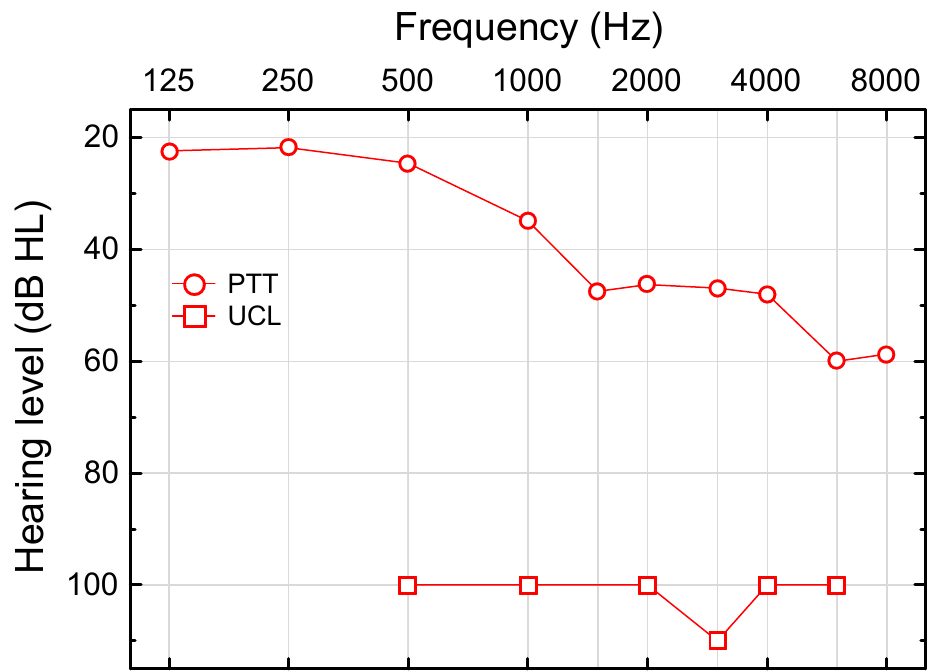
Figure 1. Median pure-tone threshold (PTT) and median uncomfortable level for pure tones (UCL) as a function of frequency in the better ear (n = 11 at all the frequencies, except for PTT at 8000 Hz, n = 10). The typical hearing dynamic range decreased from 75 dB at 500 Hz to 40 dB at 6000 Hz.